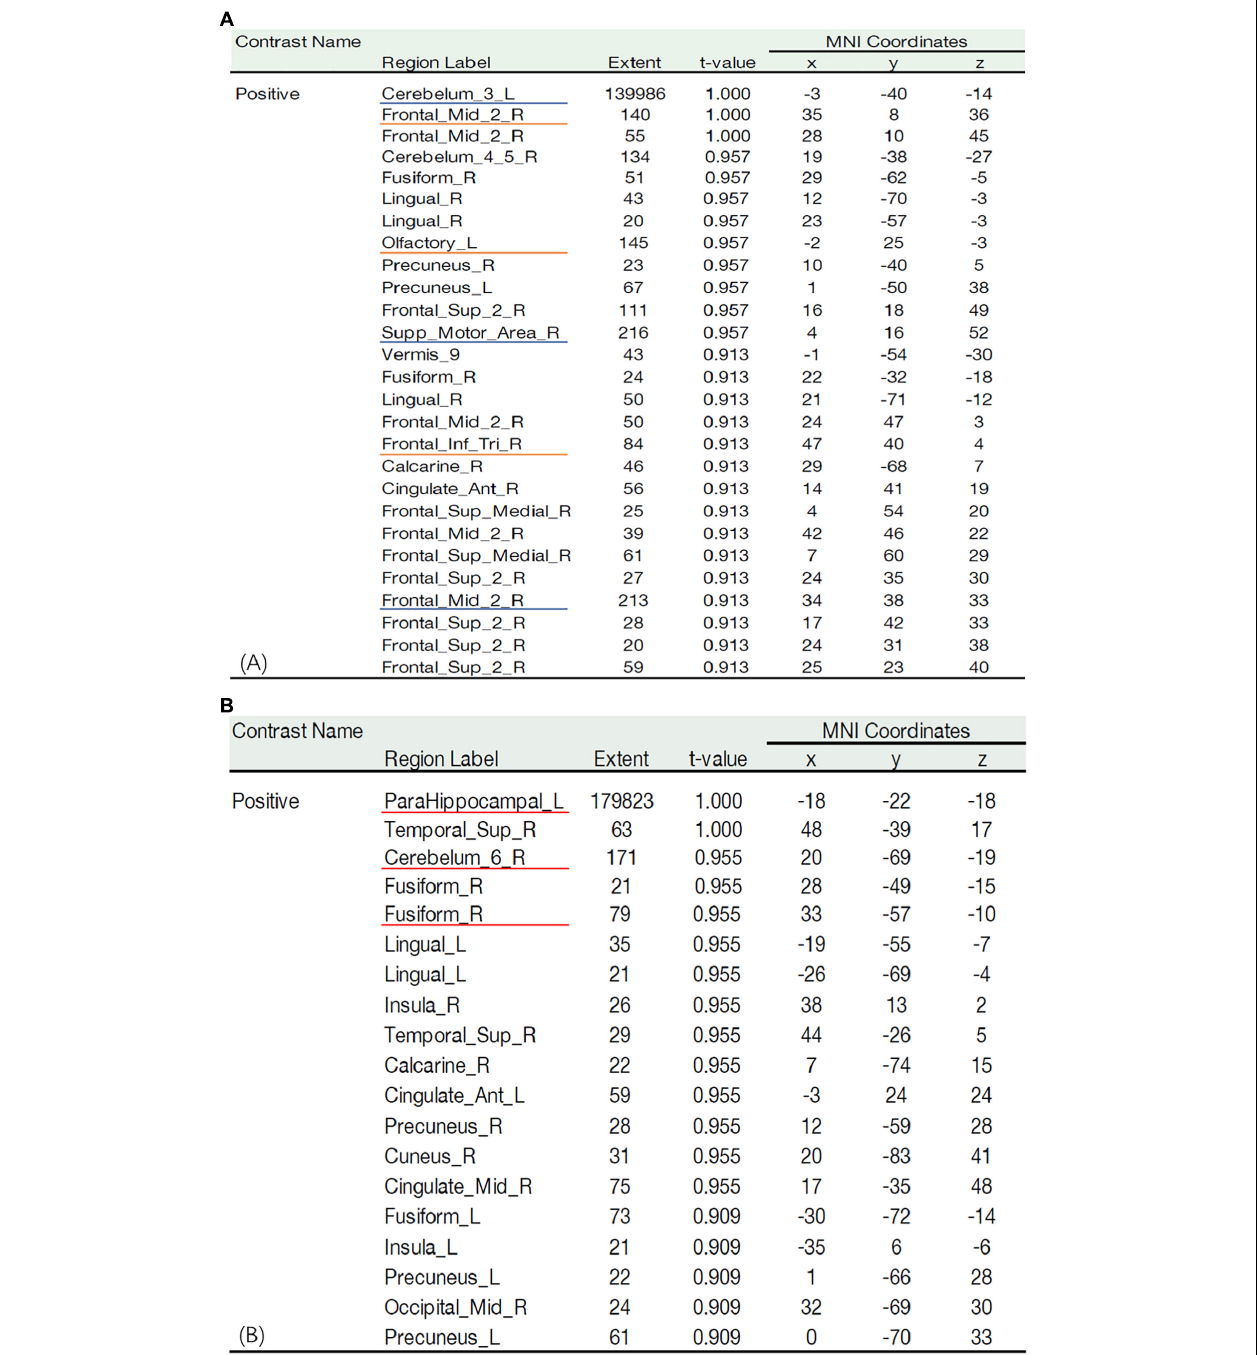
FIGURE 5 | Statistic map of the fiber probability tracking. (A) Statistic map of the fiber probability tracking in the MCI group. Blue underline is on behalf of the areas which a large number of fibers mainly reached in the MCI group. Orange underline is on behalf of some areas which can be observed in the MCI group, but can’t be observed in the NC group. (B) Statistic map of the fiber probability tracking in the NCI group. Red underline is on behalf of the areas which a large number of fibers mainly reached in the NC